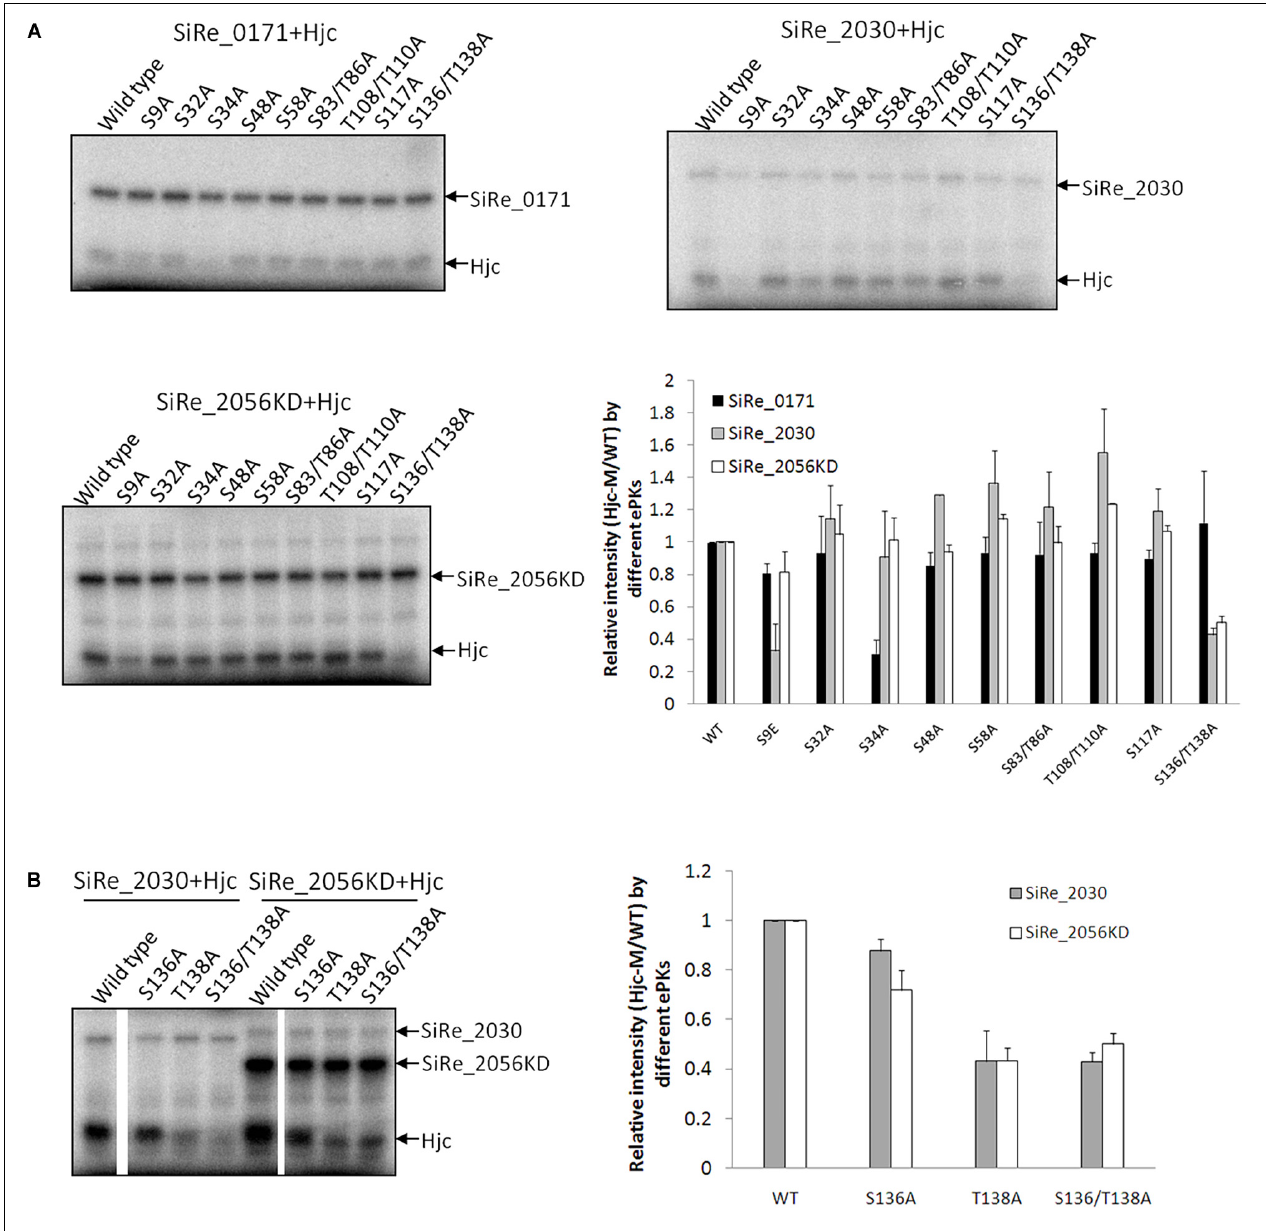
FIGURE 2 | ePKs phosphorylate Hjc at different Ser/Thr residues. (A) Phosphorylation of various Hjc mutants by SiRe_0171, SiRe_2030, and SiRe_2056KD. Representative images of Hjc phosphorylation are shown. Quantification of the autoradiographs is shown at the right bottom. (B) Phosphorylation of Hjc mutants, S136A, T138A, and S136/T138A by SiRe_2030 and SiRe_2056KD. The data was obtained from three independent experiments. Error bars indicate standard